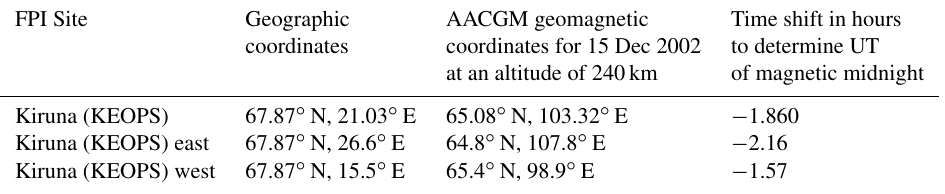
Table 1. Geographic and geomagnetic AACGM coordinates of the FPI facility related to the KEOPS site in Kiruna (see text). FPI Site